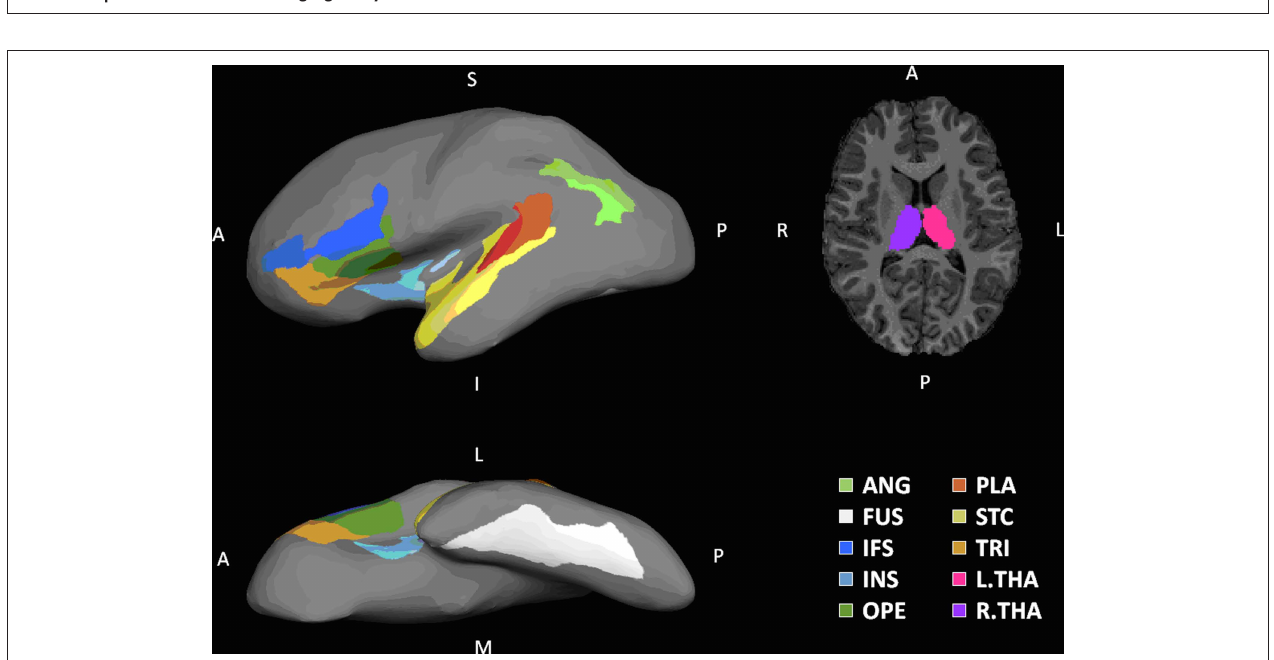
cerebral hemisphere (L, left hemisphere; R, right hemisphere), a dot following the prefix, and one of the designators: ANG, angular gyrus; FUS, fusiform; IFS, inferior frontal sulcus; INS, insula; OPE, pars opercularis; PLA, planum temporale; STC, superior temporal gyrus; THA, thalamus; TRI, pars